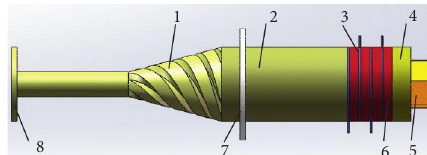
Figure 1: The overall structure of longitudinal-torsional com- pound consolidation vibration system. 1: spiral groove; 2: front cover plate; 3: electrode slices; 4: rear cover plate; 5: fastening bolt; 6: piezoelectric ceramics; 7: flange; 8: consolidation